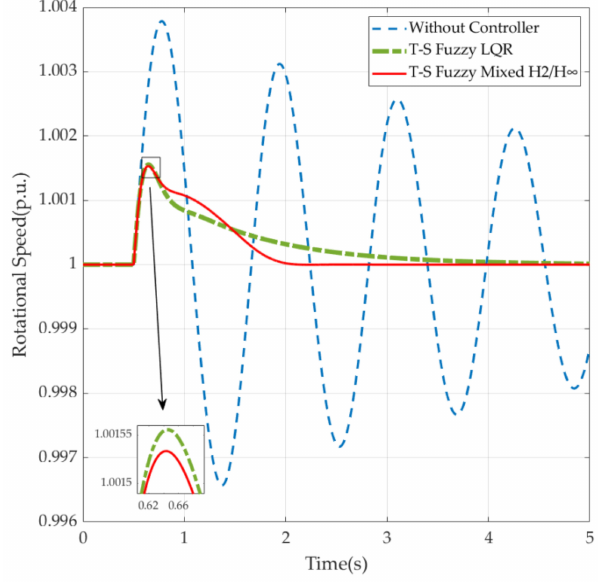
Figure 14. The curve of unit’s rotational speed change during sudden 0.2 (p.u.) load reduction.